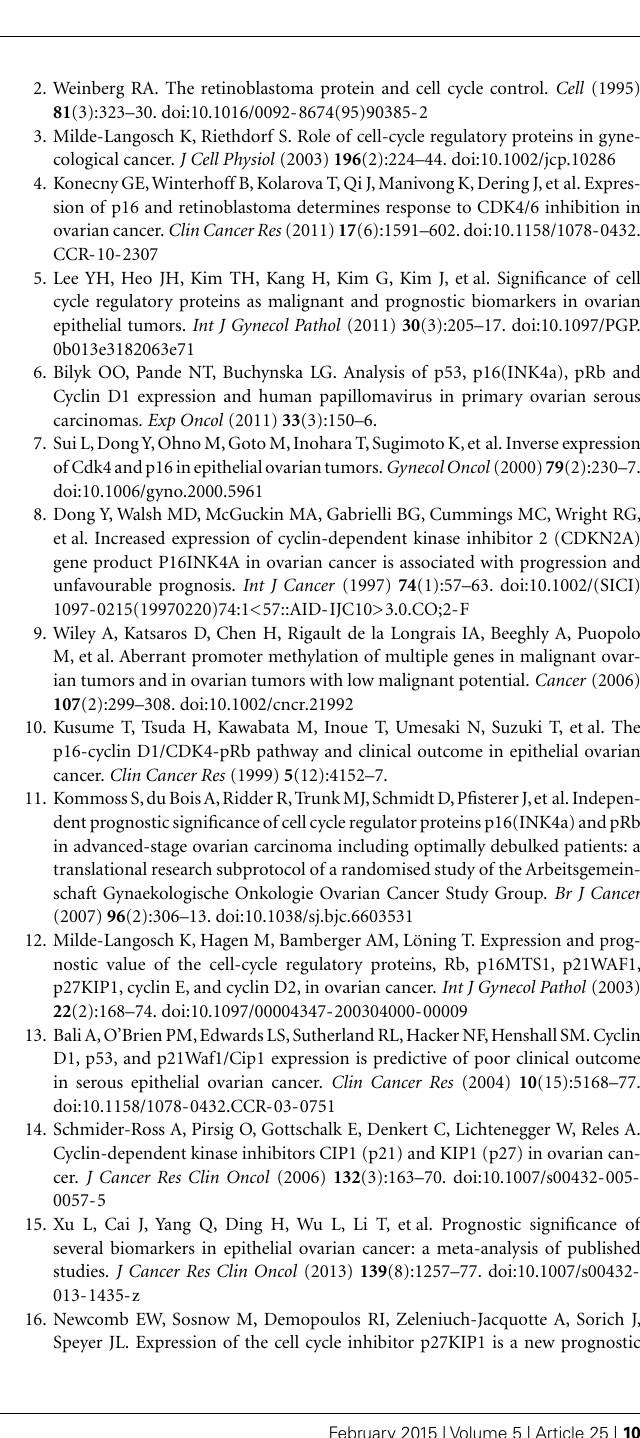
FIGURE 2 | Heat map of cell-cycle marker distributions in histologic subtypes of ovarian and endometrioid endometrial cancer patients . Abbreviations: HGS, high-grade serous; LGS, low-grade serous; ME, mixed epithelial; MUC, mucinous; EO, endometrioid ovarian cancer; CC, clear cell; EM EC, endometrioid endometrial